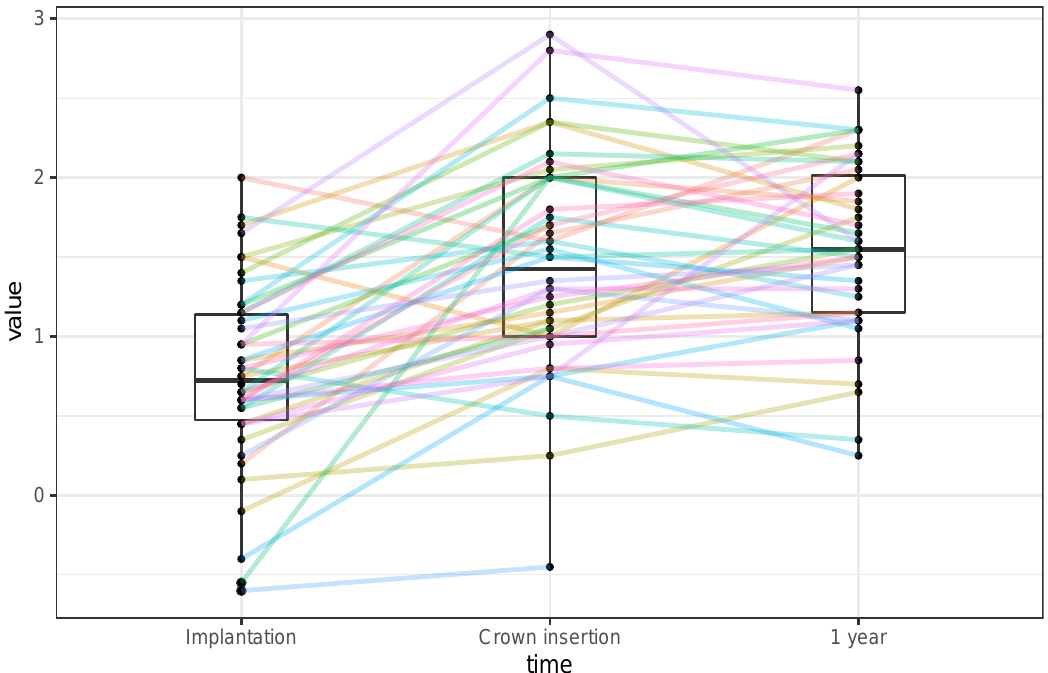
Figure 4. Individual marginal bone-level changes over time (values in mm). A mean vertical bone loss of 0.1 ± 0.49 mm was measured, distal from the mesial neighboring tooth and mesial from the distal neighboring tooth, in the observation pe- riod between implantation and loading, and a loss of 0.14 ± 0.48 mm was measured after